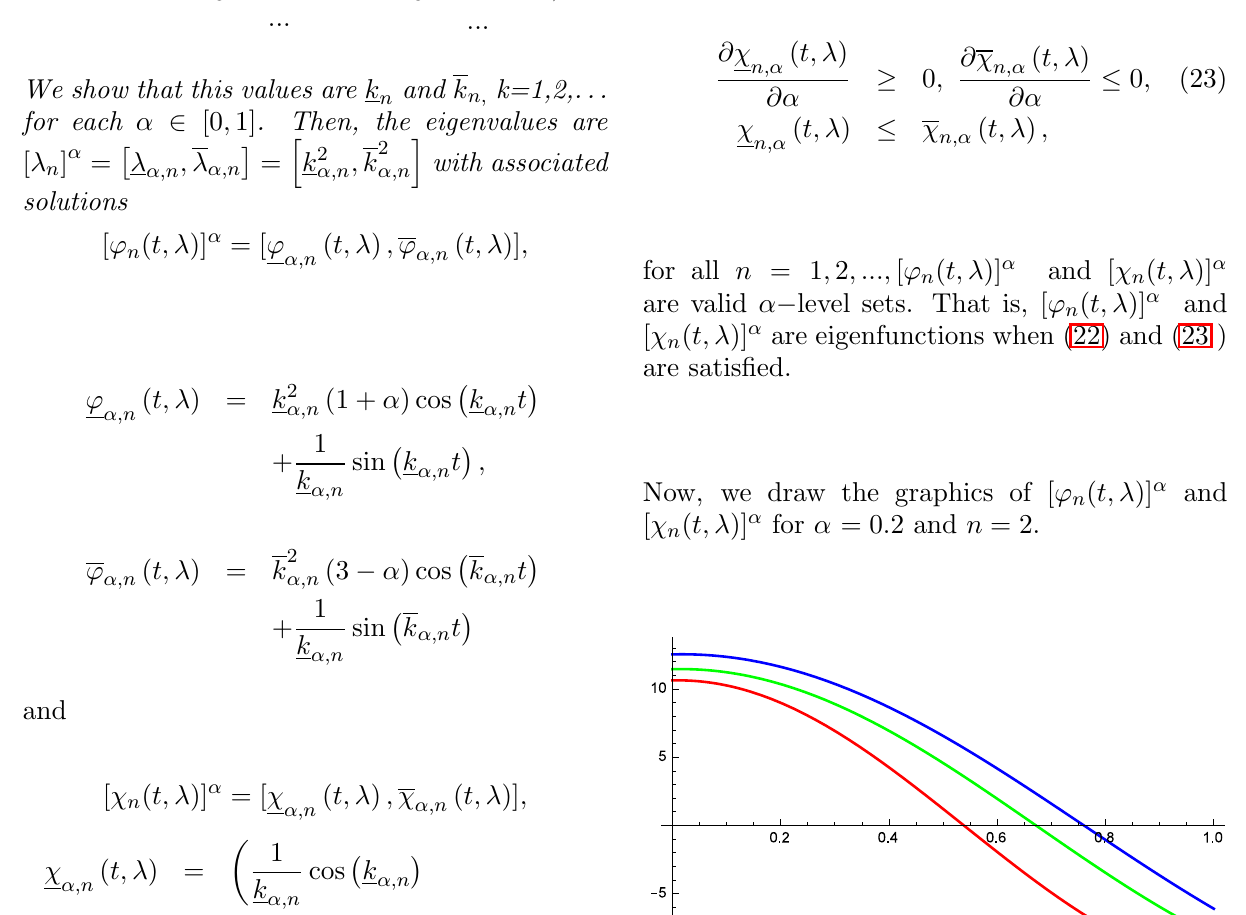
Figure 1. Graphic of [ ϕ n ( t, λ )] α : Red → ϕ ( t, λ ), Green → ϕ → ϕ α,n ϕ 1 ( t, λ ,n